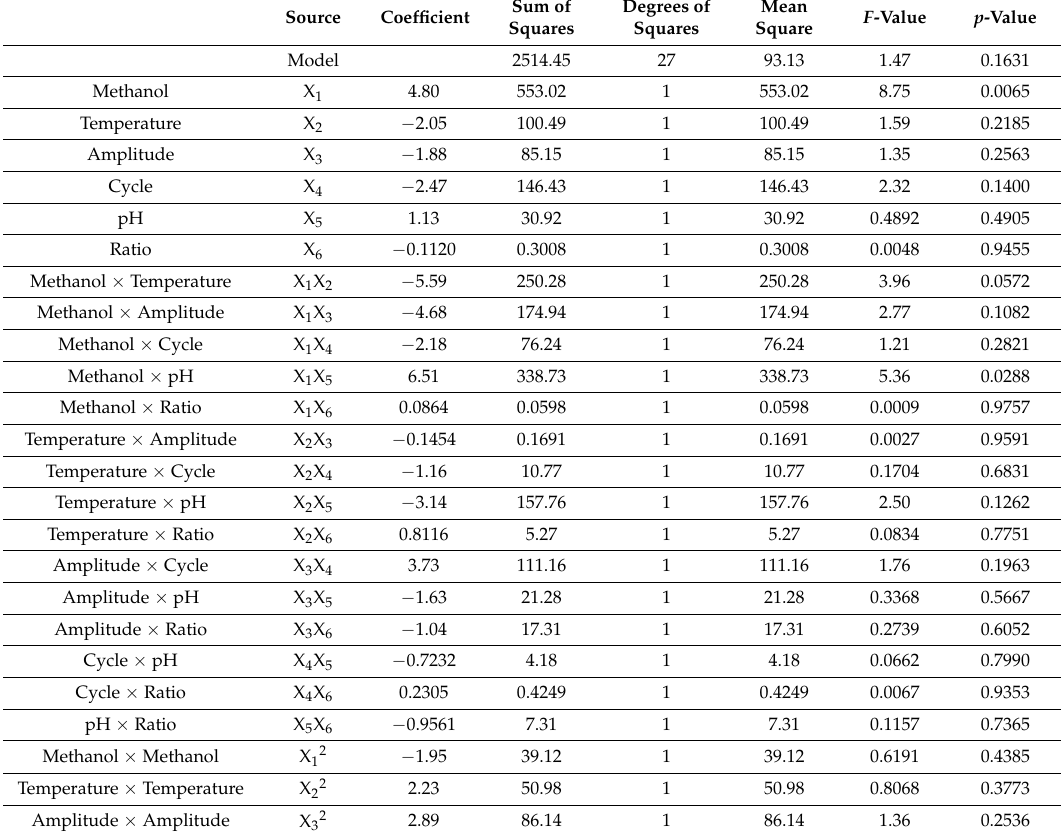
Table 3. ANOVA for the quadratic model adjusted to the extraction of total